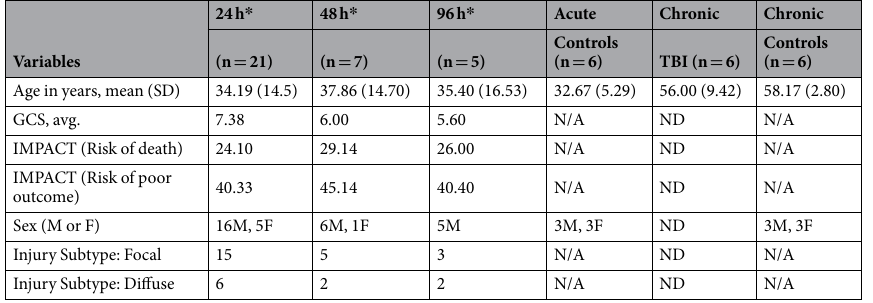
Table 1. Patient Demographics and Characteristics. GCS: Glasgow Coma Score. IMPACT: International Mission for Prognosis and Analysis of Clinical Trials (percent risk). * Blood samples obtained 24, 48 and 96 h post-TBI. 48 h and 96 h blood samples were obtained from a subset of the 24 h